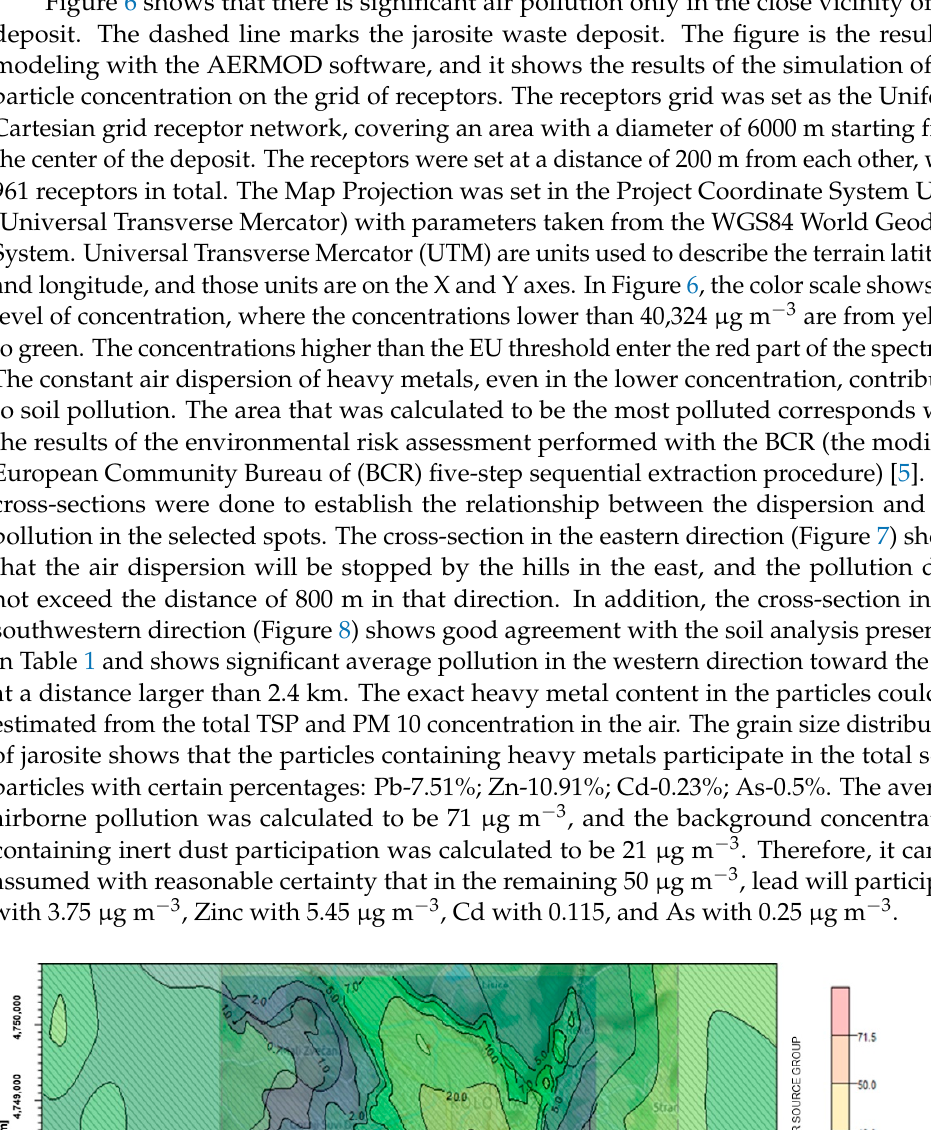
Figure 7. Cross section of the airborne pollution distribution in the east direction. Figure 8. Cross section of the airborne pollution distribution in the southwest direction.